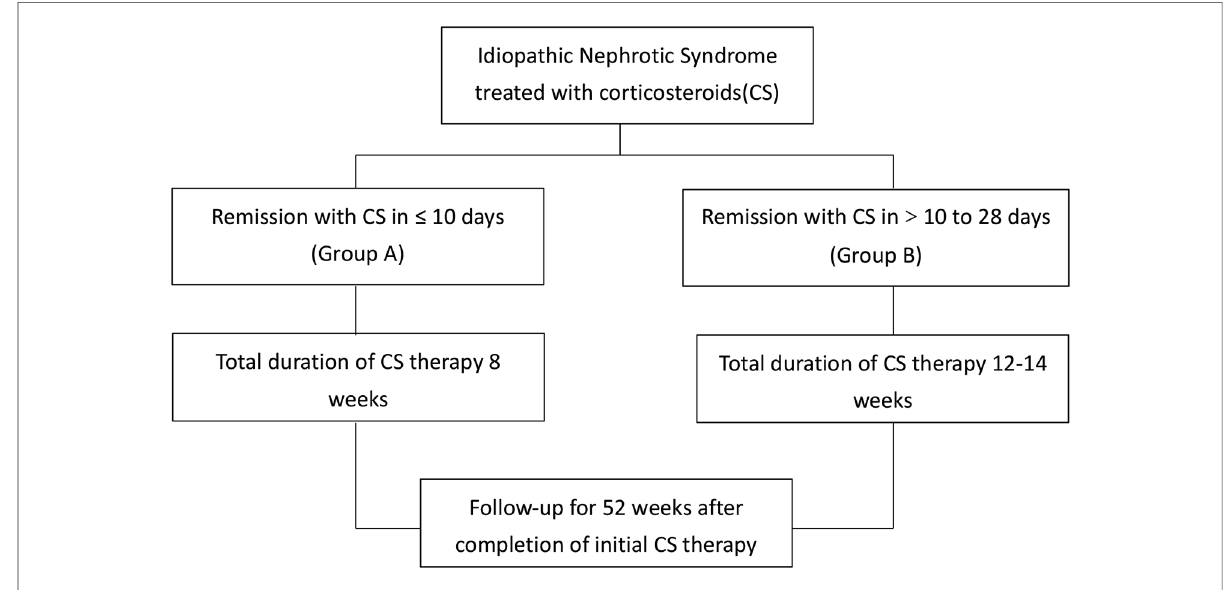
FIGURE 1 Patient grouping and study